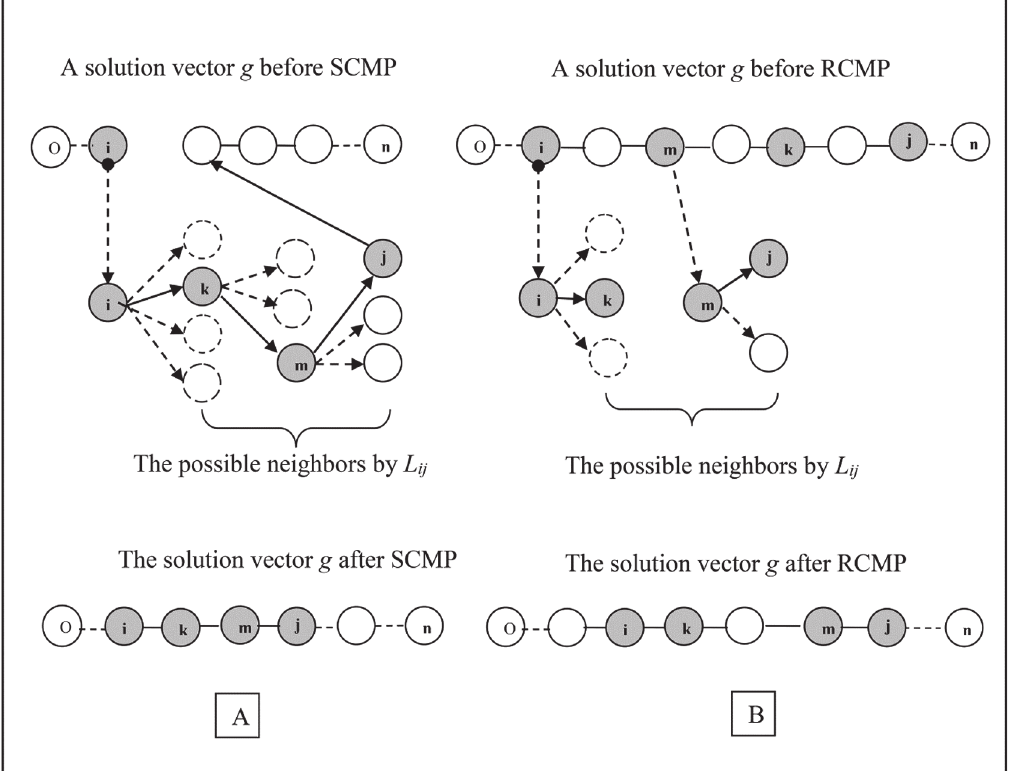
Fig 3. The idea of new mutation procedures based on using the list of neighbors L ij . (A) Sequential constructing mutation procedure (SCMP): SCMP generates a new random sequence of markers ( i-k-m-j ) from a randomly selected marker ( i ) of the solution vector g . (B) Reference-based constructing mutation procedure (RCMP): RCMP reinserts two randomly defined markers ( i ) and ( m ) of g to other positions.